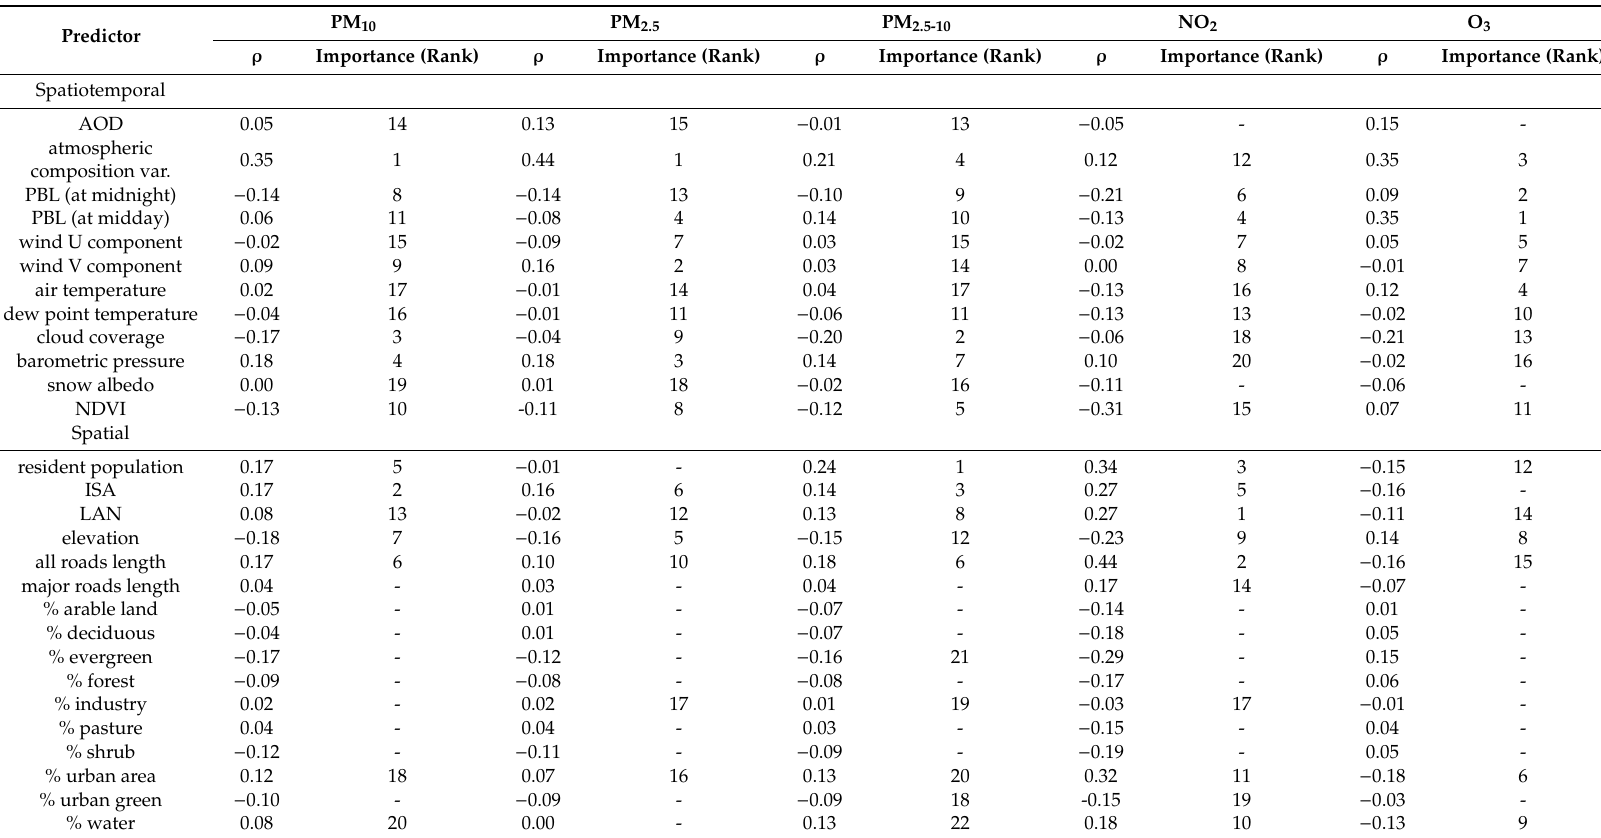
Table 2. Results of the stage 3 model: Spearman’s correlations between air pollutants and predictors, and relative importance (rank) of individual predictors in the random forest (RF) model. AOD, Aerosol Optical Depth; PBL, Planetary Boundary Layer; U, u component of the wind (horizontal wind toward east); V, v-component of the wind (horizontal wind towards north); NDVI, Normalized Di ff erence Vegetation Index; ISA, Imperviousness Surface Areas; LAN, Light At